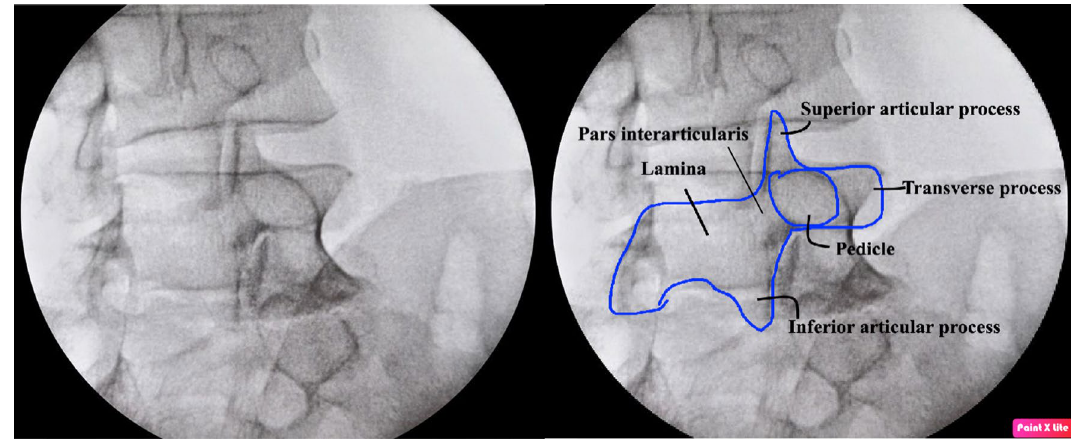
Fig. 2 Scottie Dog fluoroscopy view. The superior articular process represents the ear, the inferior articular process is the anterior limb, the transverse process is the nose and the pedicle is the eye, the pars interarticularis is the neck and the lamina is the body (Reproduced and edited from